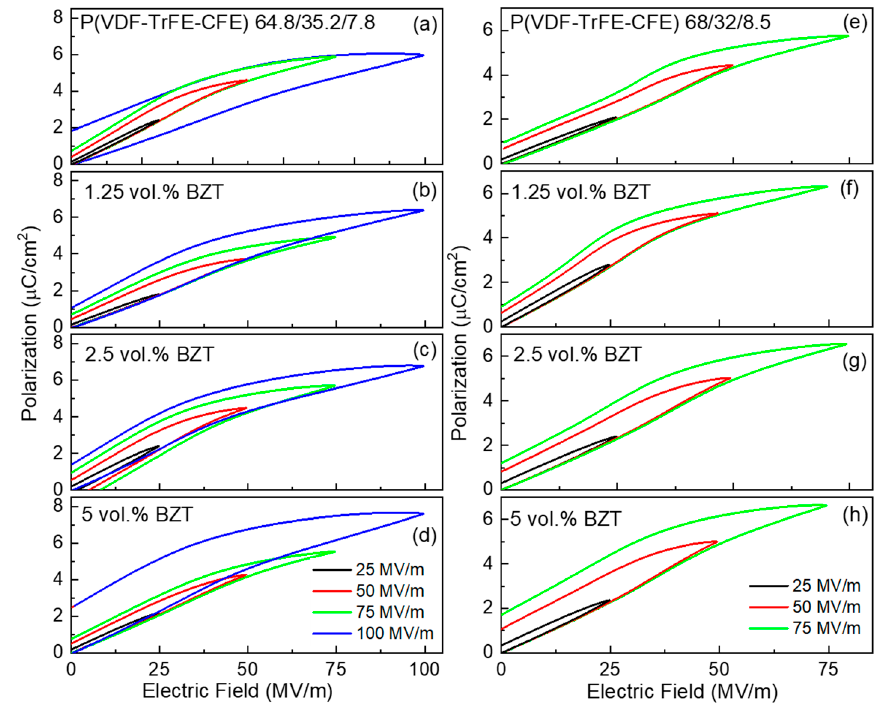
Figure 4. Unipolar polarization hysteresis loops of composite films based on P(VDF-TrFE-CFE) 64.8/35.2/7.8 ( a – d ), and 68/32/8.5 ( e – h ) terpolymers measured under triangular field of 10 Hz at room temperature.